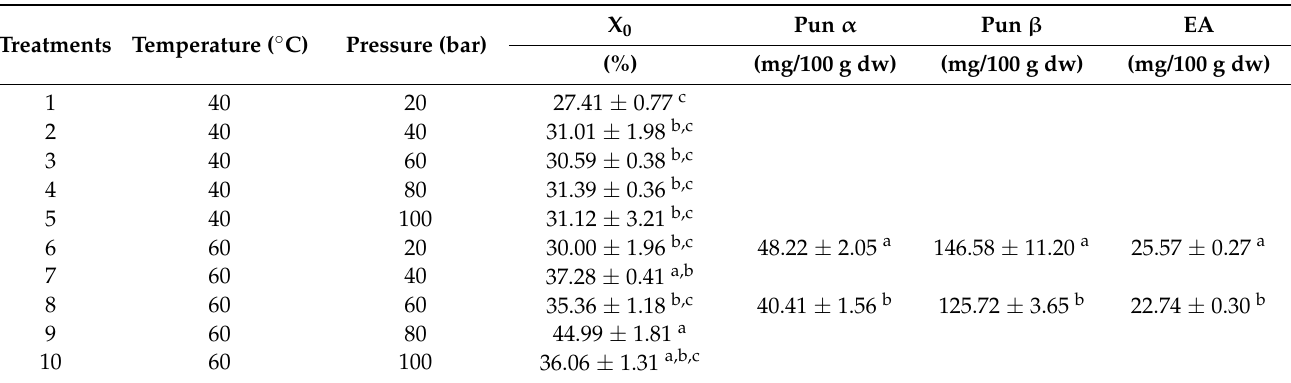
Table 1. Global extraction yields (X 0 ) and PPCM target phenolic compounds content obtained assessing temperature and pressure by